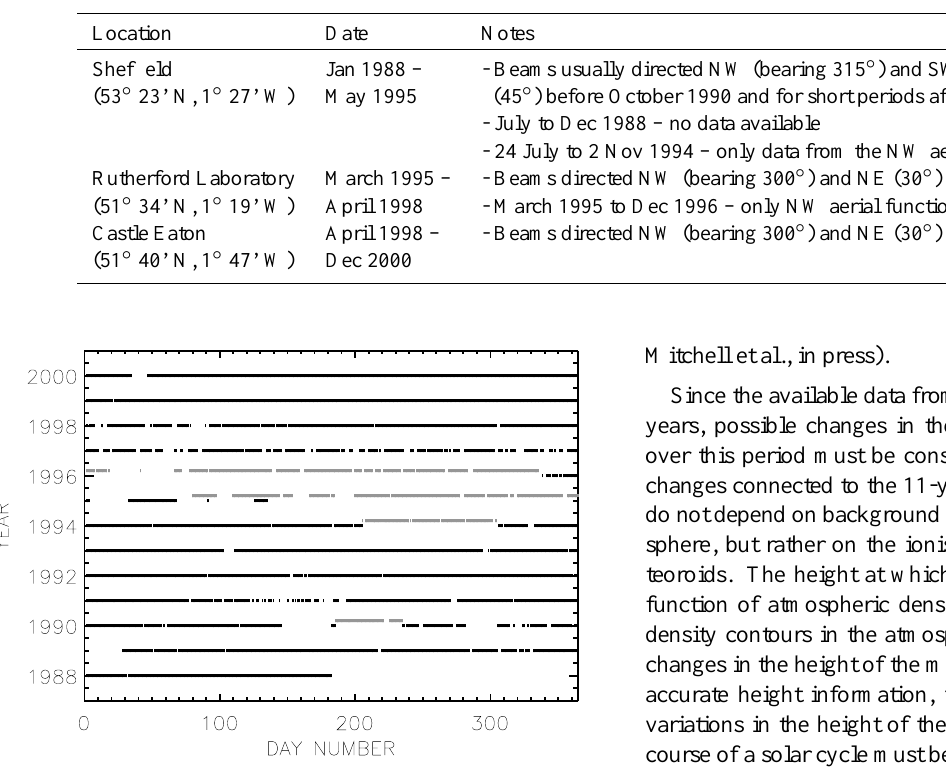
Table 1. Details of the radar’s location over the period of 1988–2000. Note that during the interval of March 1995 to May 1995, observations were made at both Sheffield and RAL